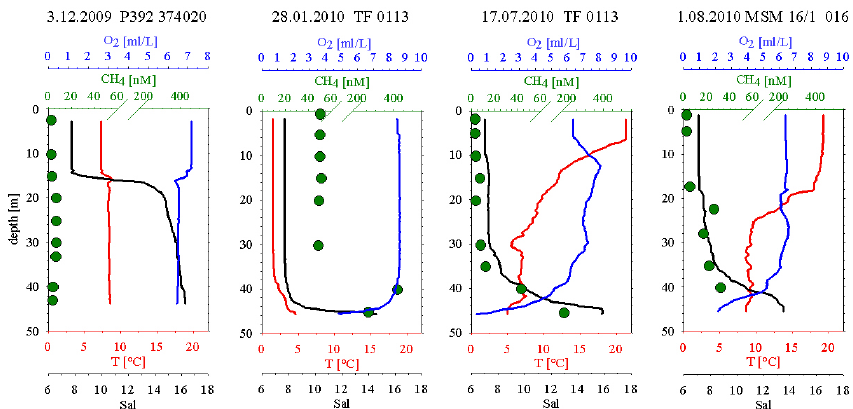
Fig. 5. Data of water column properties and methane concentration of profiles at station TF0113 taken during four cruises in December